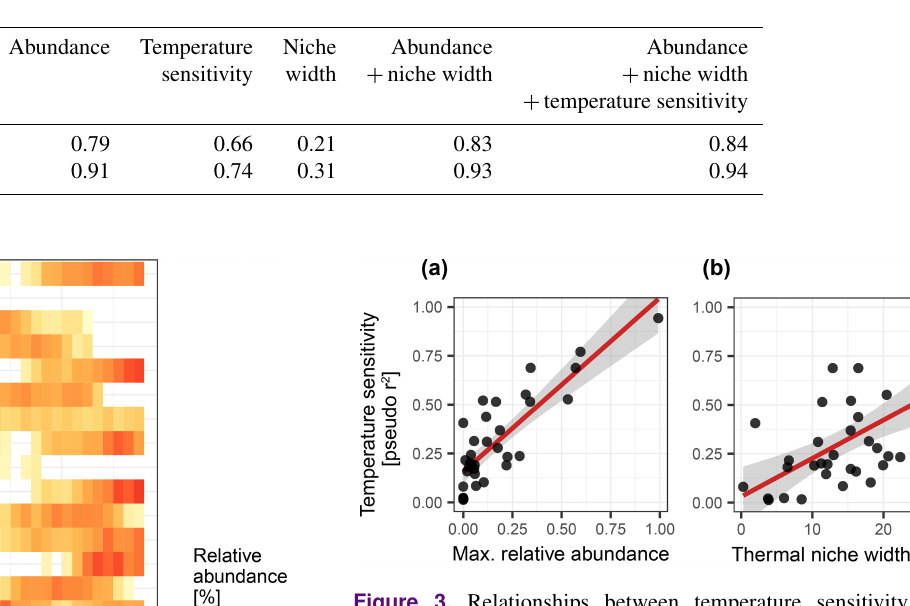
Table 1. Factors explaining species importance: coefficient of determination of linear regression between species importance and maximum abundance, thermal niche width, and temperature sensitivity.